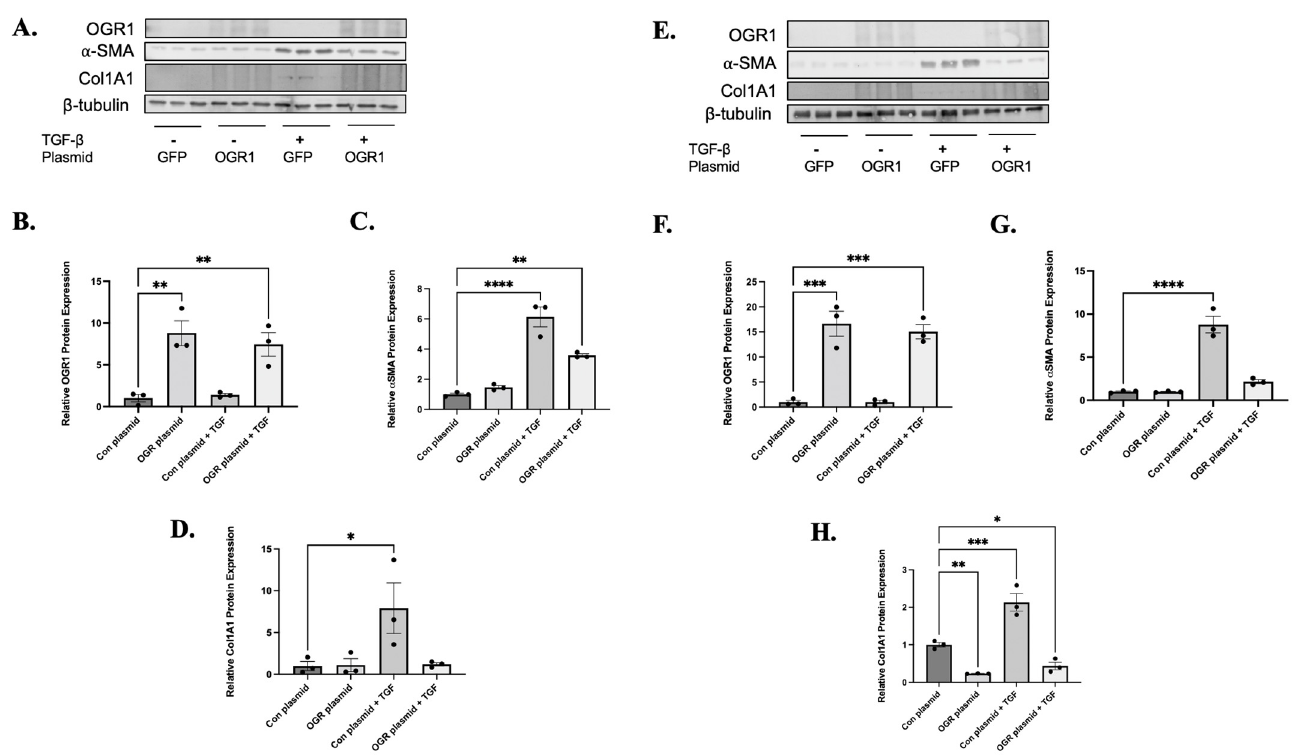
Figure 4. OGR1 overexpression reduces the ability of TGF- β to induce myofibroblast differentiation. Human fibroblasts (healthy: A – D , IPF: E – H ) were transfected with a plasmid expression GFP (con) or OGR1 and were subsequently treated with either TGF- β 1 or DMSO as a control. Protein lysates were then harvested and western blotting was performed with antibodies against OGR1, α -SMA, collagen 1A1, and beta-tubulin (as a loading control). Representative western blots are presented in ( A and E , respectively), and densitometry analysis is graphed below. OGR1 plasmids were successfully expressed in both healthy ( B , ** p = 0.0020 and 0.0065) and IPF-derived fibroblasts ( F , *** p = 0.0002 and 0.0004). As expected, TGF- β 1 significantly increased expression of α -SMA in both healthy ( C , **** p < 0.0001) and IPF-derived fibroblasts ( G , **** p < 0.0001). However, overexpression of OGR1 attenuated TGF- β 1-induced α -SMA expression in healthy fibroblasts ( C , ** p = 0.0017) and IPF fibroblasts ( G , difference between con plasmid + TGF- β 1 and OGR plasmid p = 0.0025 by Student’s t -test). Again, as expected, treatment with TGF- β 1 caused increased collagen1A1 expression in healthy ( D , * p = 0.0364) and IPF fibroblasts ( H , *** p = 0.0008). Again, OGR1 overexpression led to significant reductions in TGF- β induced collagen in healthy ( D , p = 0.009 by Student’s t -test) and IPF fibroblasts ( H , * p = 0.0027 by student t -test). Interestingly, in IPF fibroblasts, OGR1 overexpression decreased collagen expression in an unstimulated state ( H , ** p = 0.0084). Data represent mean expression ± SEM.